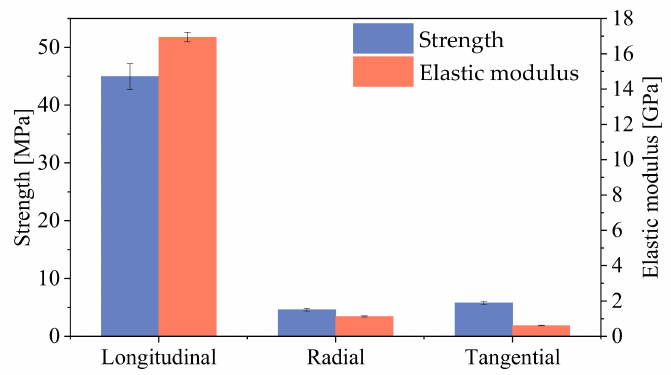
Figure 4. The compressive strength and elastic modulus of larch samples in different directions.